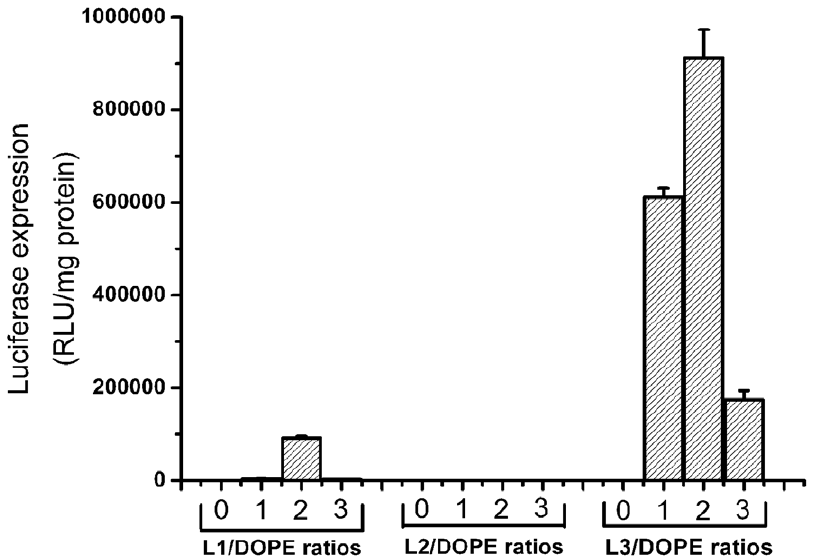
Figure 7. Transfection efficiencies of lipoplexes formed from L1–L3 at various lipid/DOPE ratios by keeping the N/P ratio at 2 (for L1 and L2) and 10 (for L3) in A549 cells. Concentration of the DNA was 2 m g/well. Data are expressed as relative light units (RLU)/mg of protein.